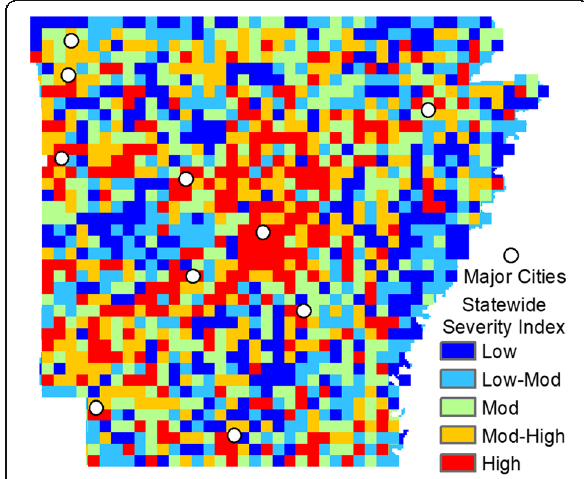
Fig. 12 Summed statewide severity index. Pattern indicates the natural tendency of hazardous weather to affect the central portion of Arkansas and shows protected zones across the state. Each grid cell equals 10 × 10 km